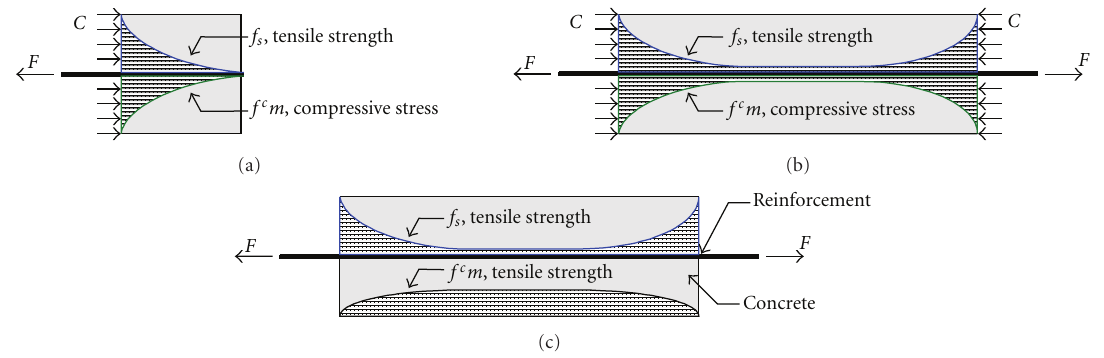
Figure 4: Typical stress distributions for (a) one side pull-out, (b) both sides pull-out, and (c) axial tension.